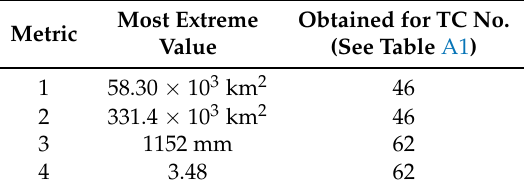
Table 5. Most extreme values taken by the IP metrics based on the 64 landfalling TCs from the WRF model outputs.